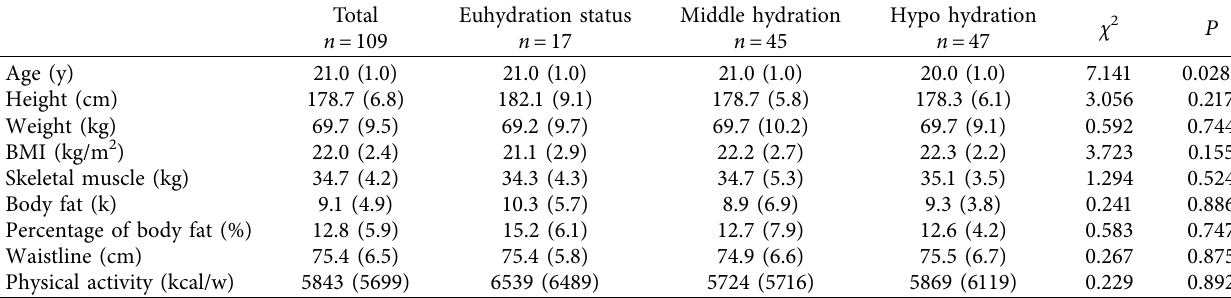
Table 1: Characteristics of